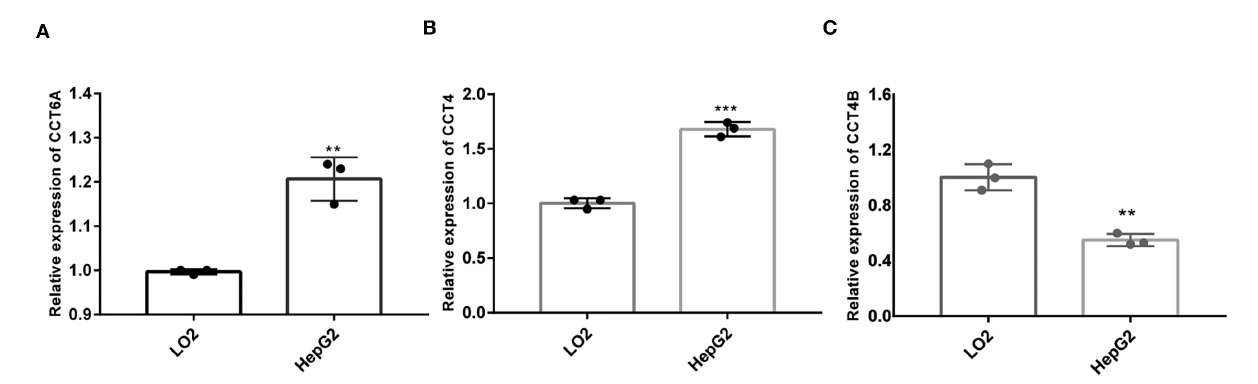
FIGURE 13 | Comparison of mRNA expression between HepG2 and LO2 on CCT4 and CCT6A. (A) CCT6A mRNA expressions in two cell lines. (B) CCT4 mRNA expressions in two cell lines. (C) CCT6B mRNA expression in two cell lines. ** P < 0.01; *** P < 0.001.